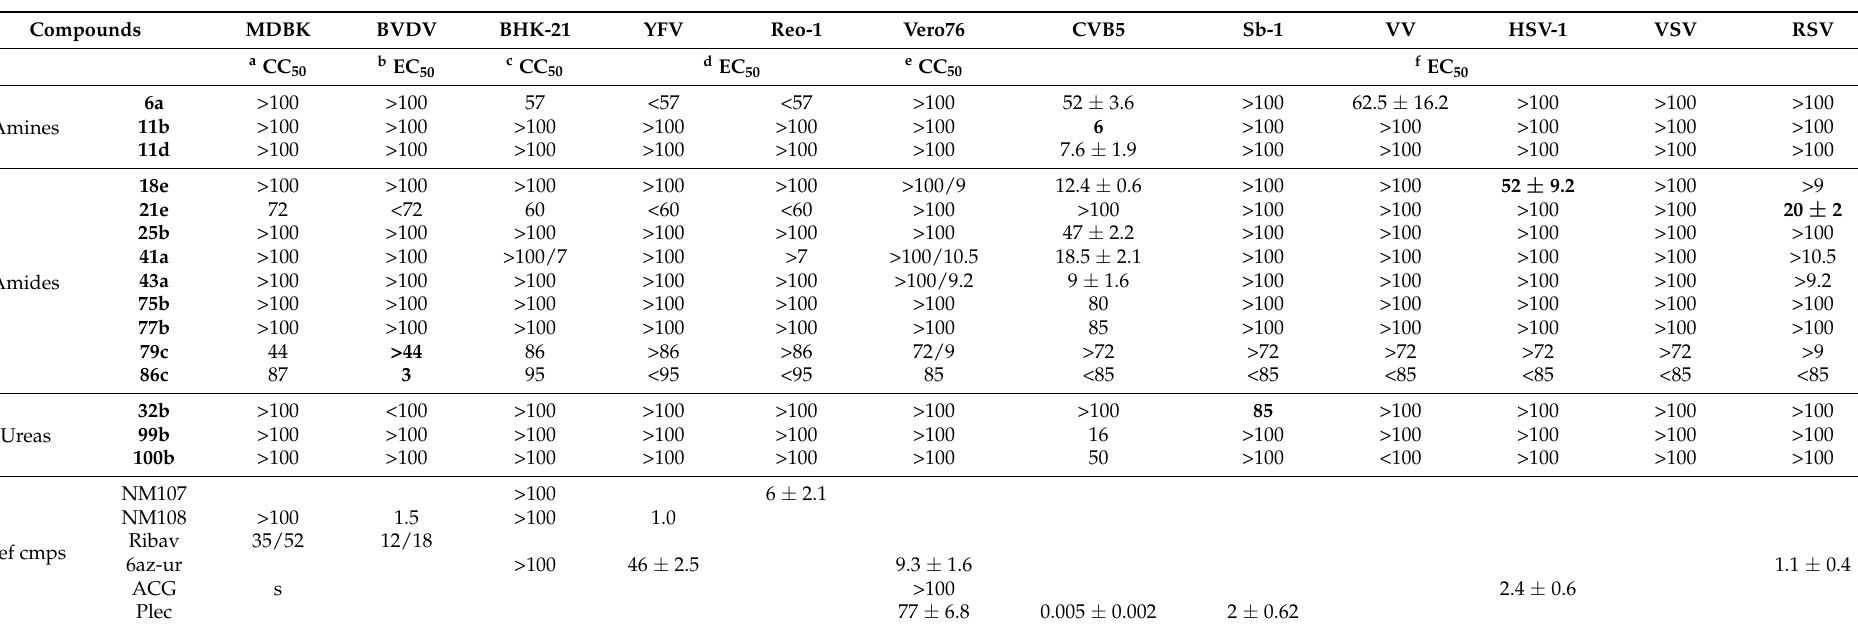
Table 1. Cytotoxicity and antiviral activity of the sole active derivatives against one or more among the following viruses: BVDV, YFV, Reo-1, CVB5, Sb-1, VV, HSV-1, VSV, and RSV. Data represent mean values of three independent